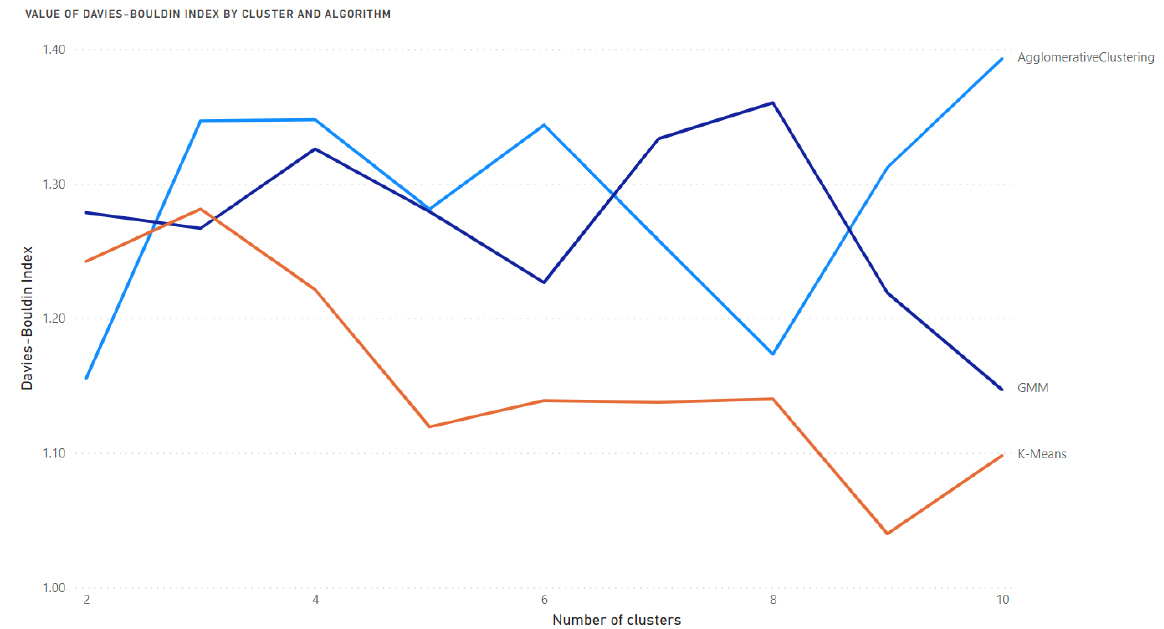
Figure 4. Value of the Davies-Bouldin index for 3 selected algorithms and the various number of clusters.